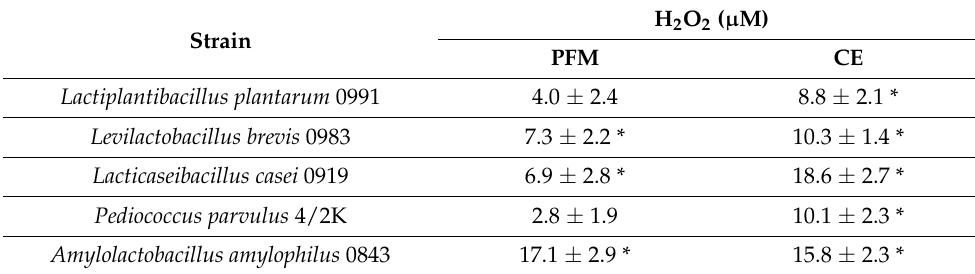
Table 4. Hydrogen peroxide release in alive Caco-2 cells after 24 h exposition to 5% ( v/v ) post- fermentation media (PFM) and cell extracts (CEs). Each data point represents the mean ± SD, n ≥ 4. * Results that are significantly different from unexposed control, p ≤